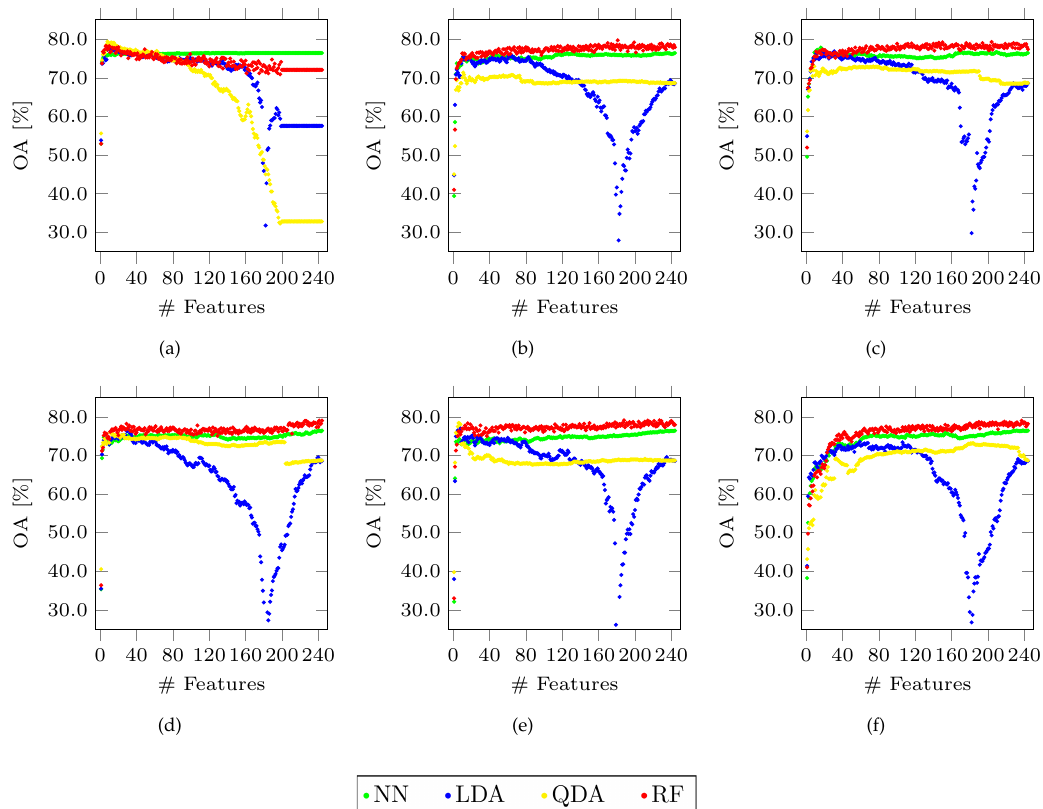
Figure 9. Classification results derived for the EnMAP dataset (20 classes) via sequential forward selection when using ( a ) the PCA; ( b ) the RF-MDPA; ( c ) the GRM; ( d ) the MUI; ( e ) the TUI and ( f ) the BOFR. Table 4. Classification results derived with the Random Forest (RF) classifier for the Salinas dataset (16 classes).